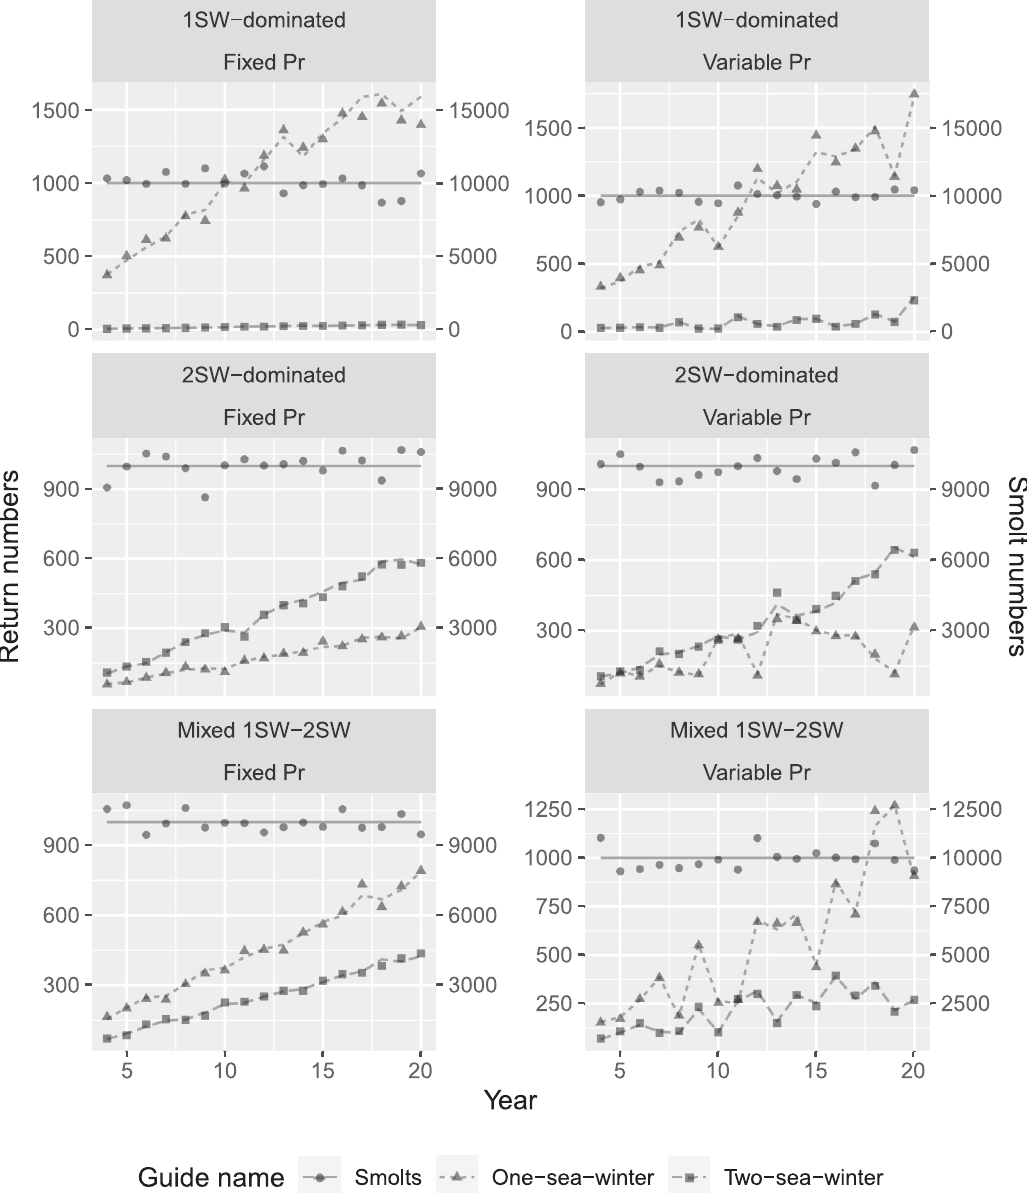
Fig 1. Simulated time series of returning adult salmon abundance in the six scenarios. The lines denote the simulated abundance estimates without observation error while the points are the same estimates including observation error.